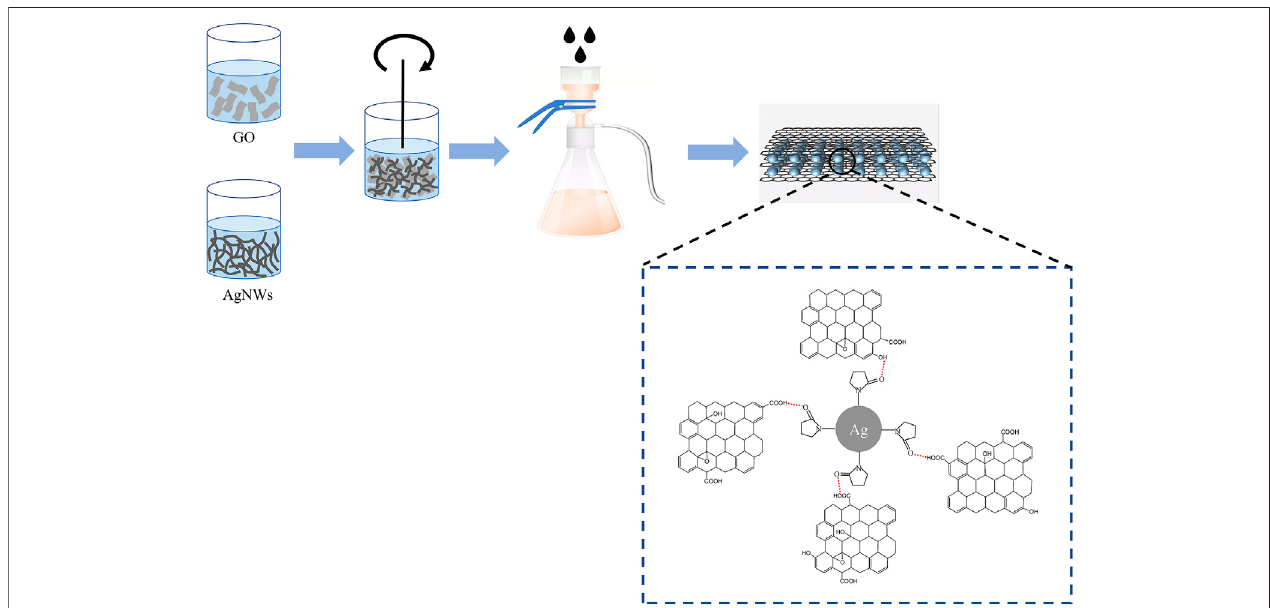
FIGURE 1 | Schematic illustration for the fabrication of rGO/AgNWs